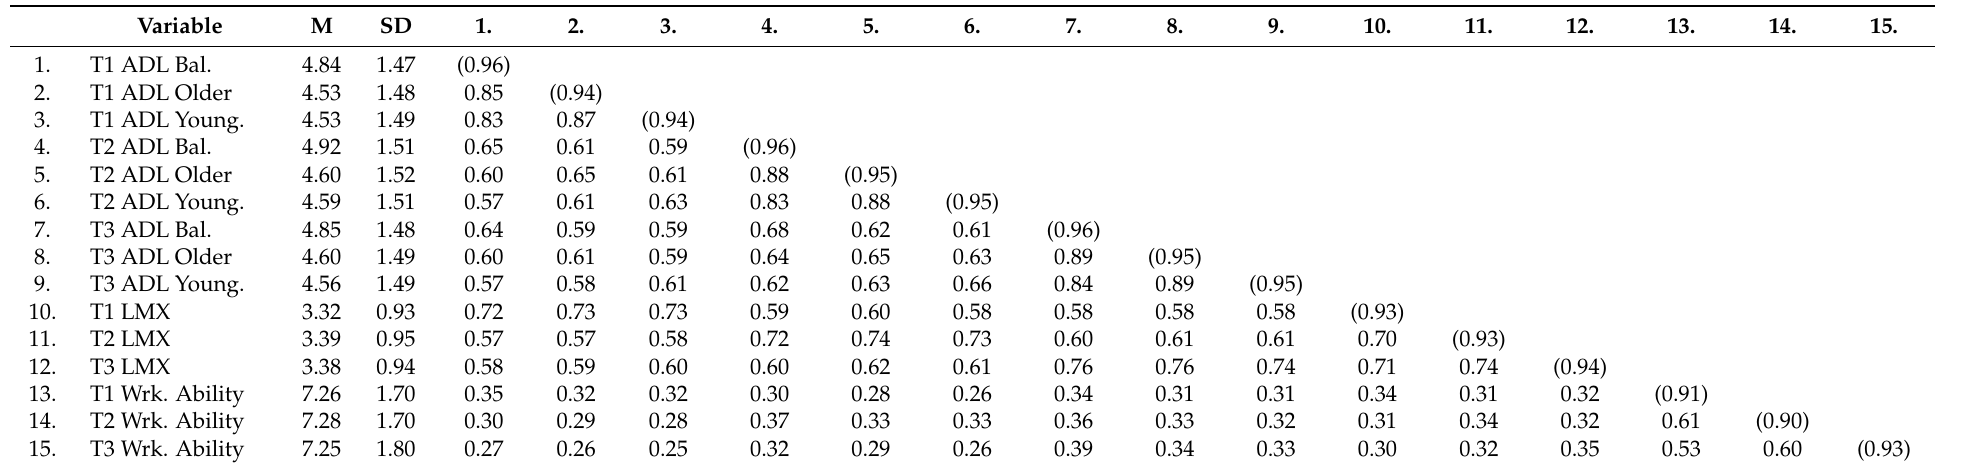
Table 2. Descriptive Statistics and Intercorrelations Among Substantive